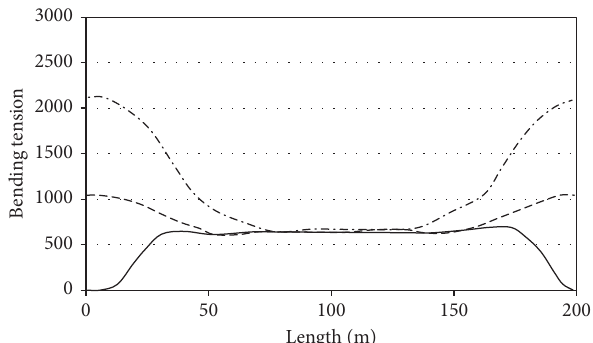
Figure 7: Variation in the extent of maximum bending tensions along the pipeline with different final conditions.